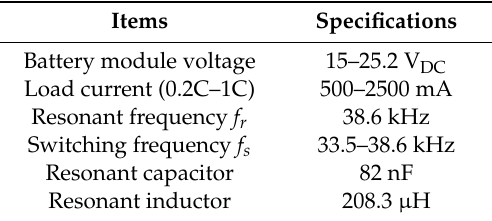
Table 1. Related parameters of the main circuit.